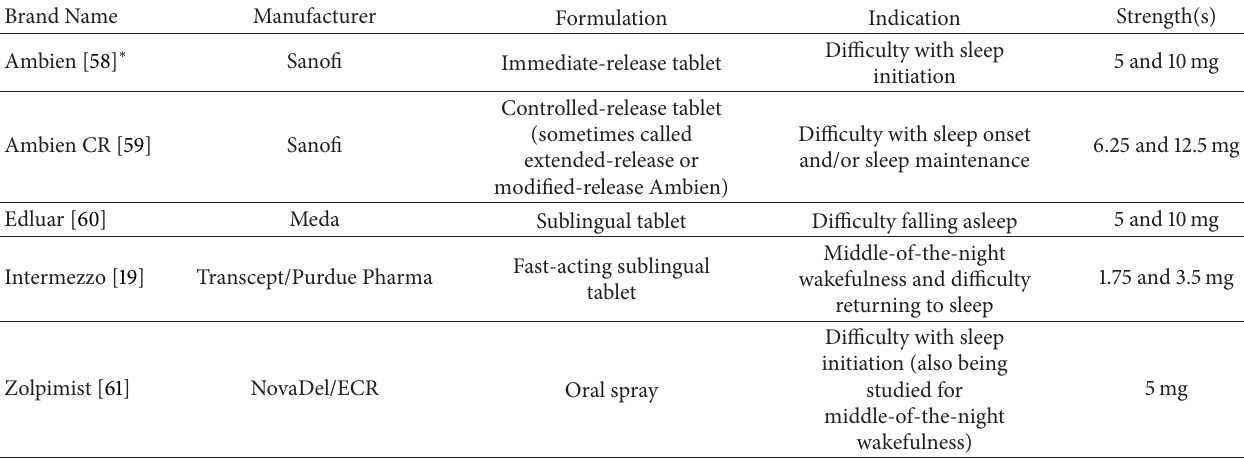
Figure 2: The pentameric structure of the GABA A receptor is composed of 4-transmembrane monomeric subunits (a disulfide bond in the N - terminal extracellular domain, characteristic of the family of cys-loop receptors which includes the GABA A receptor, is depicted). Zolpidem allosterically enhances Cl − influx, which hyperpolarizes the neuronal transmembrane potential (at I), thereby making it less likely to fire in response to excitatory input (at E). Table 1: Zolpidem products currently marketed in the United States for treatment of insomnia. Zolpidem 10mg tablets are marketed in Australia under the trade name